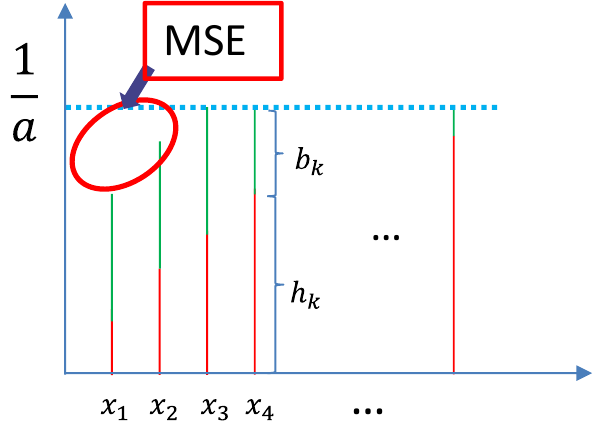
Figure 2. MSE in the signal caused by low channel gain (the length of a line represents the abso- lute value of a variable).